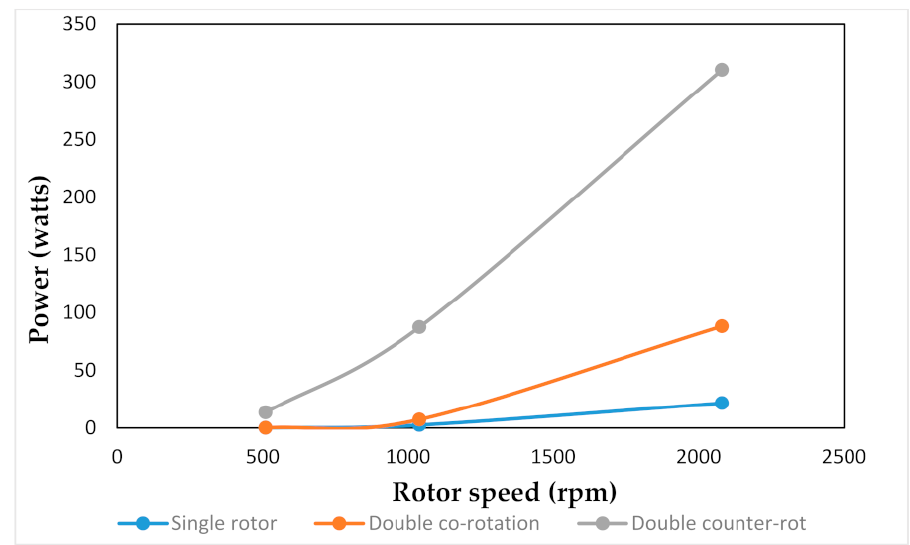
Figure 7. Power consumption under different modes of operation and